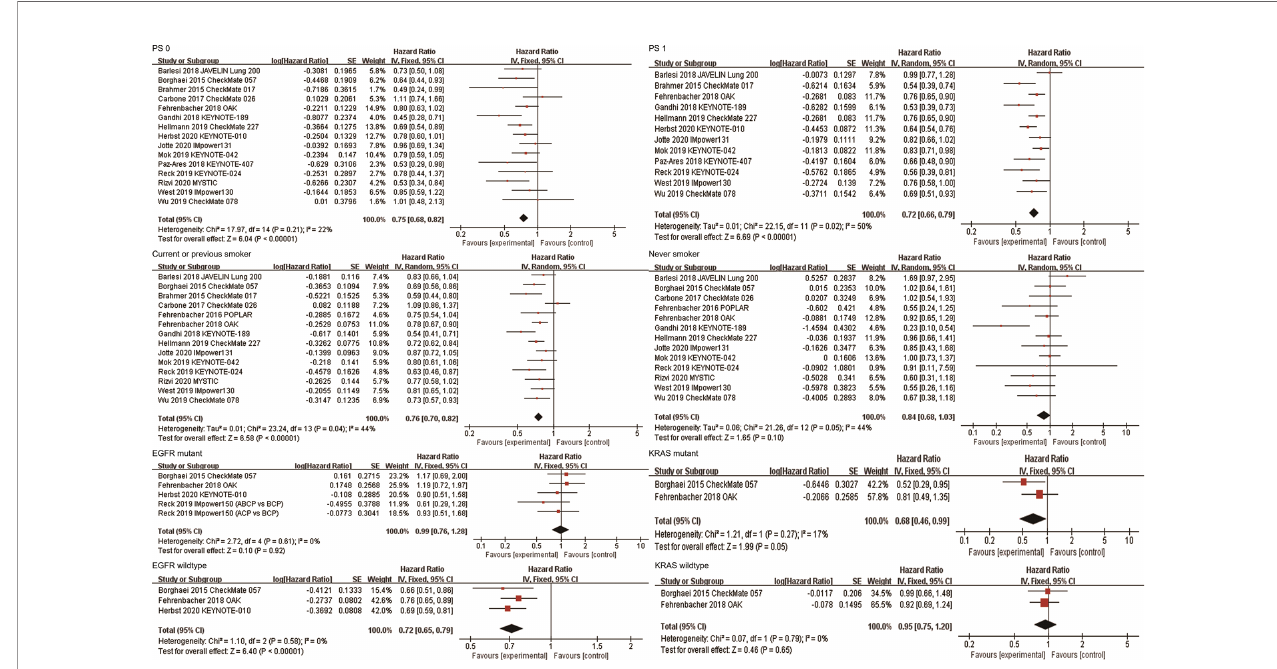
FIGURE 4 | Forest plots of hazard ratios comparing overall survival between patients treated with anti-PD-1/PD-L1-based therapy or non-ICI therapy according to PS score, smoking status, and driver mutations. PD-1, programmed death-1; PD-L1, programmed death-ligand 1; ICI, immune checkpoint inhibitor; PS, performance